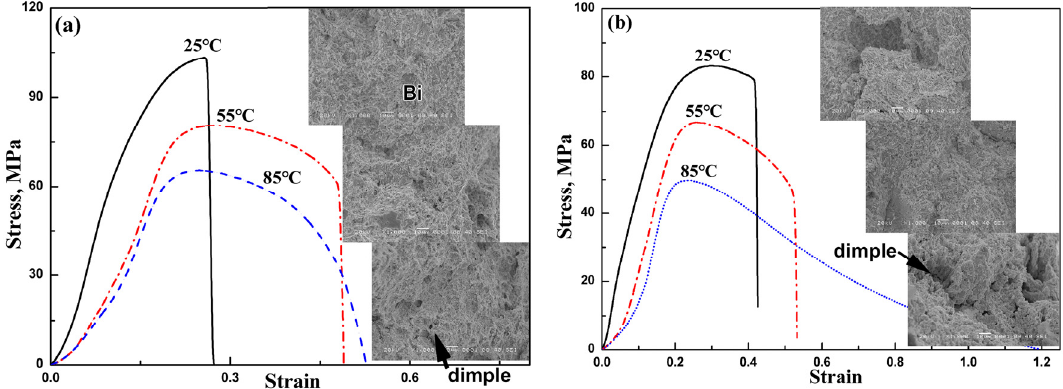
temperature. ( a ) the tensile strength; ( b ) the elongation.